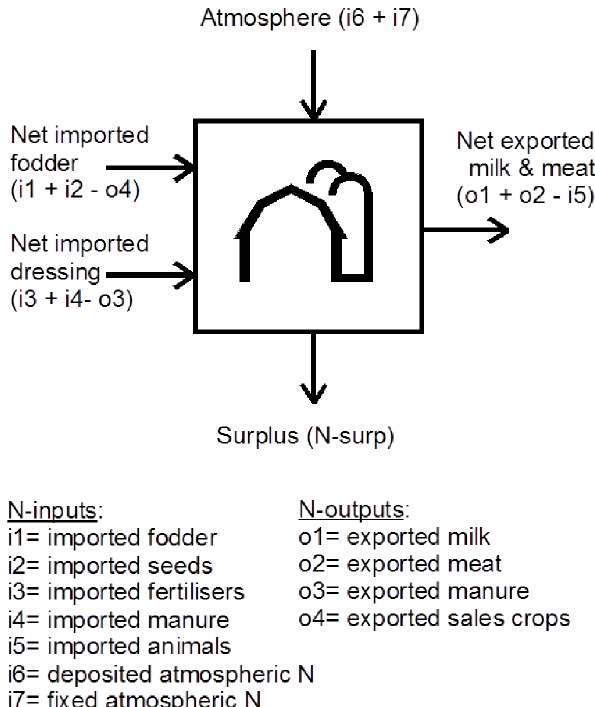
Fig. 3. Farm N-inputs (i1–i7), N-outputs (o1–o4) and surplus (N- surp) (from Dalgaard et al., 1998). The same balance can be cal- culated for a number of farms within a landscape. In this context “exported meat” (o2) also includes N in the form of live animals, eggs and wool sold, and the term “dressing” is used as the sum of synthetic fertilisers and animal